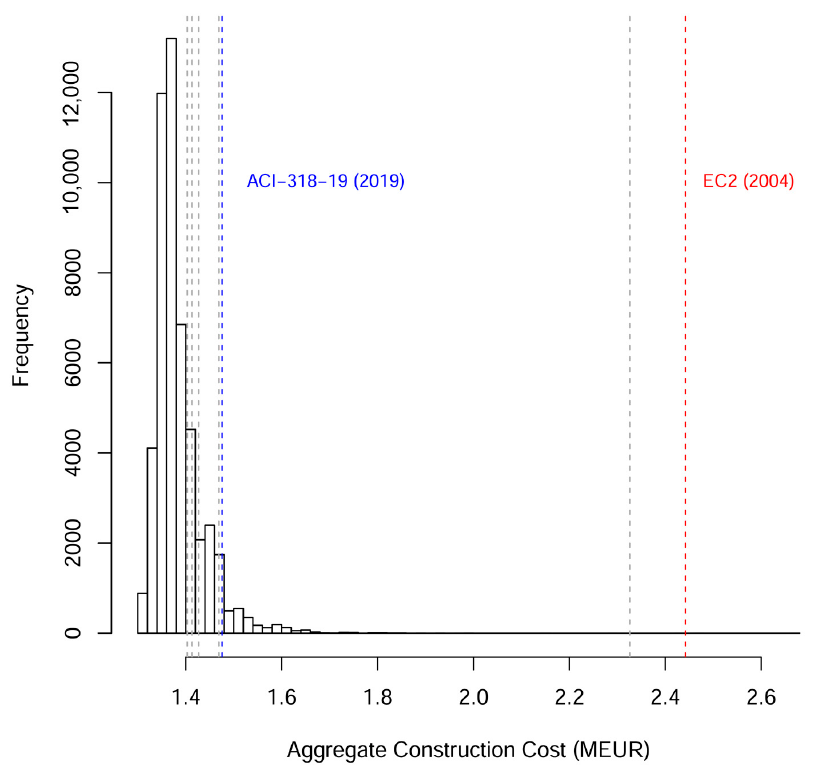
Figure 4. Histogram of building underpinning costs depending on the assumed value for the bond stress: ACI-318-19 (2019) [14], EC2 (2004) [20]. stress: ACI-318-19 (2019) [14], EC2 (2004)